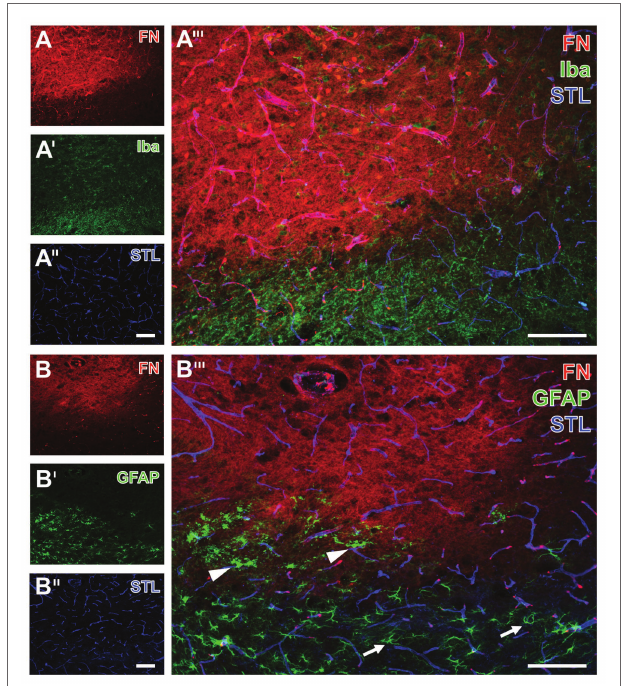
FIGURE 5 | Spatial relationships between fibronectin, the vasculature, neurons, and oligodendroglia in mice subjected to 24 h of experimental focal cerebral ischemia. Staining of fibronectin (FN, A,B ) and striatal endothelia visualized by a lectin-based technique using Solanum tuberosum lectin (STL, A '' ,B '' ) combined with the detection of neurons (NeuN, A ' ) show a regular configuration of NeuN in the non-affected area (arrows with dashed lines in A ''' ). Significant neuronal degeneration is visible toward the ischemic region with a co-occurring increase of the FN signal, starting in the ischemic border zone with shrunken NeuN (arrows in A ''' ) and passing over to the area of maximum ischemic affection with only fragments of NeuN (arrowheads in A ''' ). The concomitant visualization of oligodendroglia in the ischemia-affected neocortex reveals an increased immunosignal of the applied marker CNP (B ' ) , not overlapping with FN (B ''' ) . Scale bars: in A ''' and B ''' = 100 μ m, in A '' (also valid for A and A ' ) and B '' (also valid for B and B ' ) = 100 μ m.